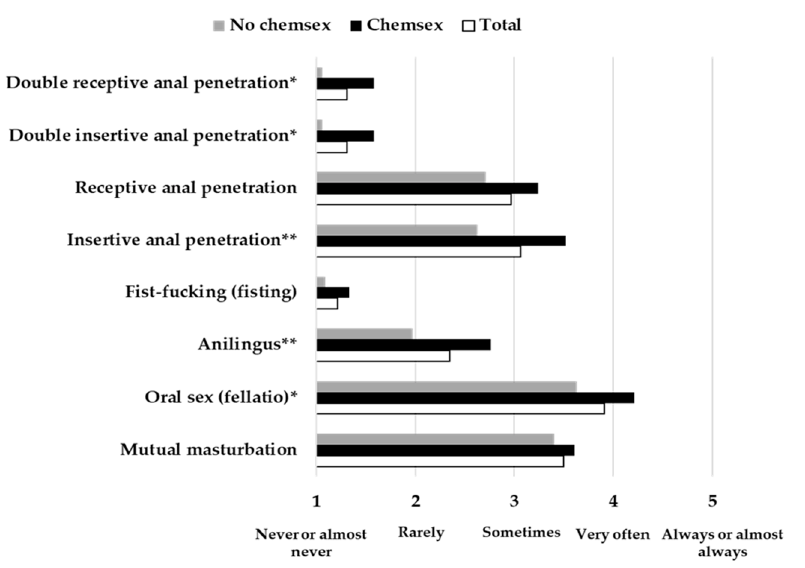
Figure 2. Frequency of sexual practices for all participants and for practitioners and non-practitioners of Chemsex separately, with occasional sexual partners. * p < 0.05, ** p <